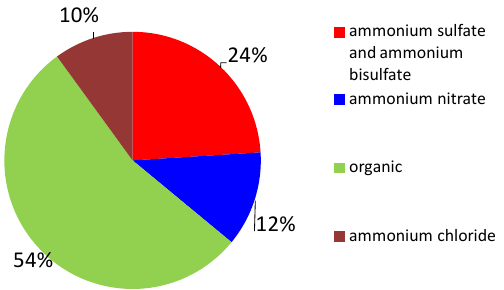
Figure 12. Averaged light-scattering contribution of each aerosol component during the haze